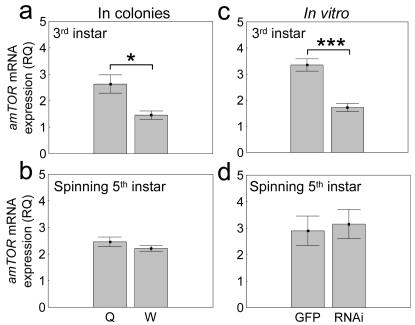
Relative quantities (RQ) of amTOR mRNA levels in honey bee larvae.In colonies a–b, queen- (Q) and worker-destined (W) larvae are characterised by a transient two-fold difference in amTOR expression (present in 3rd instar larvae, absent in spinning 5th instar larvae). In vitro c–d, RNAi was calibrated to decrease amTOR about two-fold in 3rd instar knockdowns (RNAi) vs. controls exposed to GFP derived dsRNA (GFP). Suppression was transient, as often observed with RNAi. Thereby natural expression patterns of amTOR were mimicked (a–b vs. c–d). Bars are means±s. e. (asterisk P<0.01, three asterisks P<1.0 10−6).